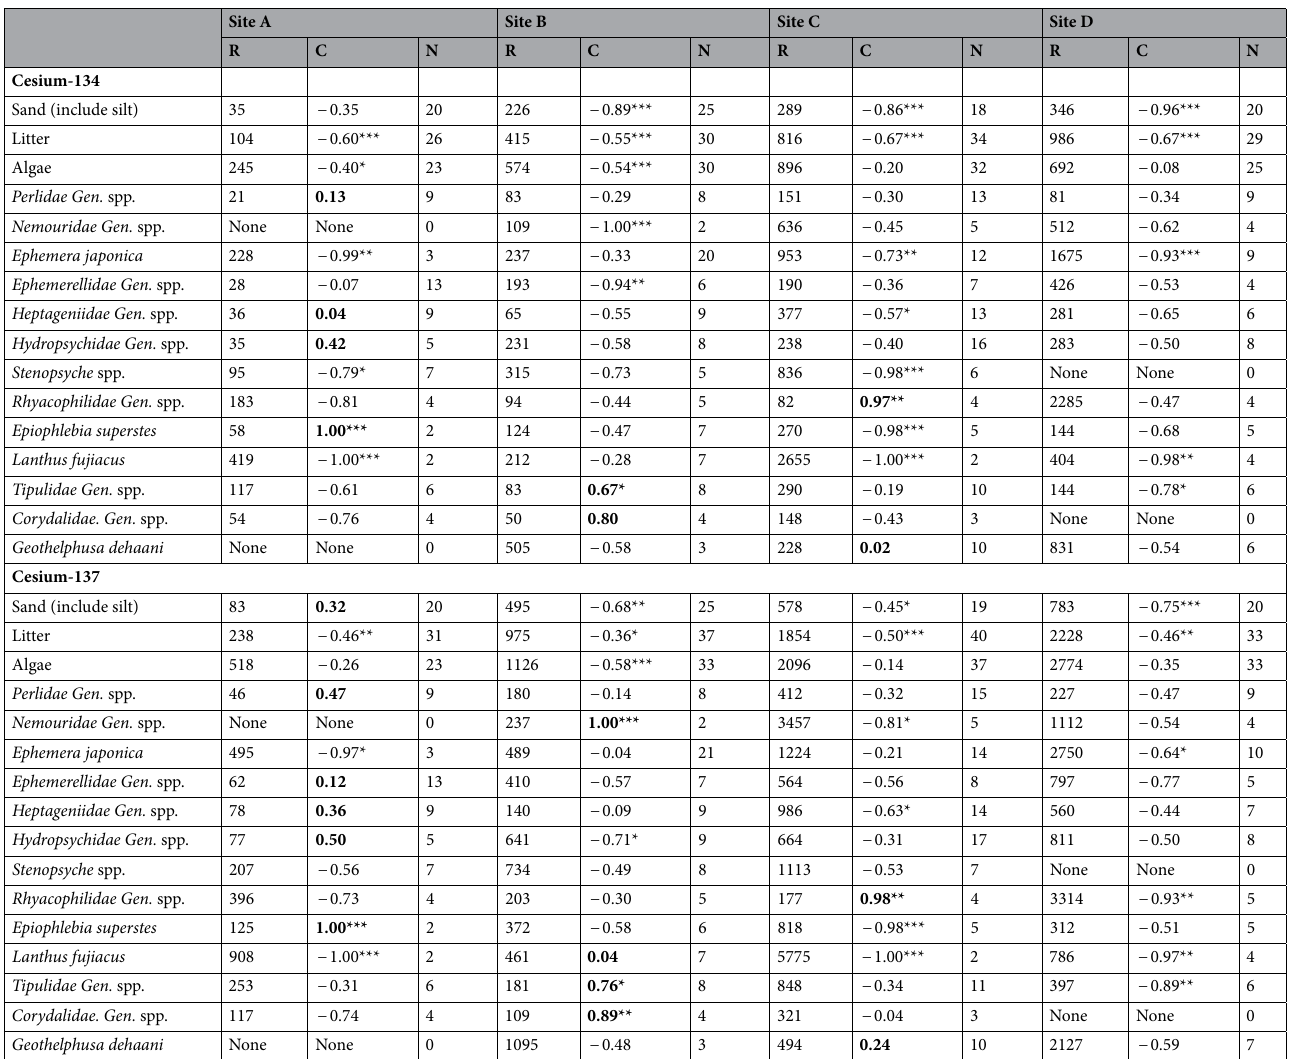
Table 2. Estimated radiocesium concentration using regression curve (R) and the correlation coefficient between the cesium-134 and ccesium-137 concentrations and the years after accident in 16 groups (C) and the number of samples tested (N) at A, B, C and D sites. R: Estimated radiocesium concentration on 1 September, 2013 by the equation (Bq/kg of dry weight), C: correlation coefficient, N: number of sampling data, Bold